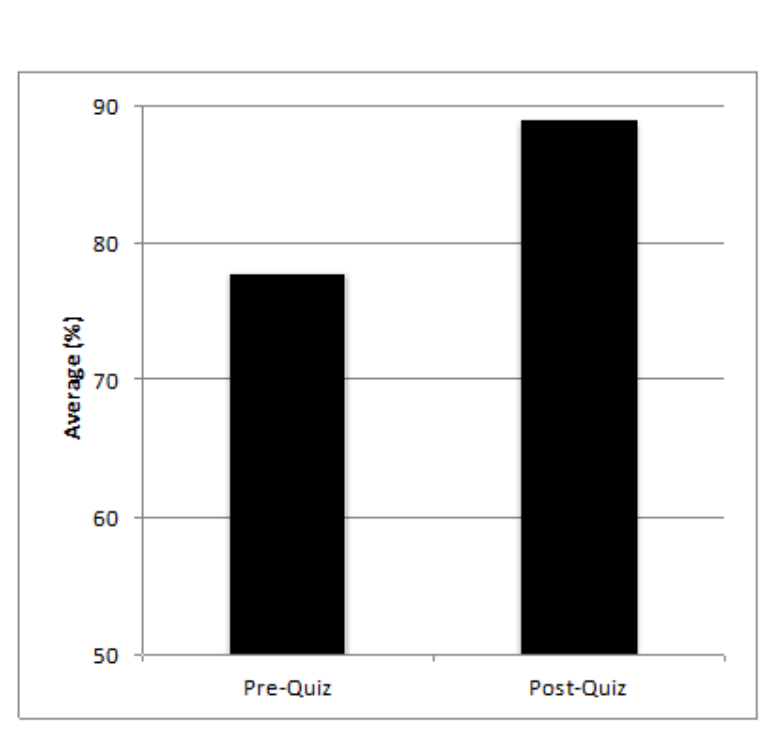
Figure 10. The overall averages for the question for drawing a series circuit for the experimental